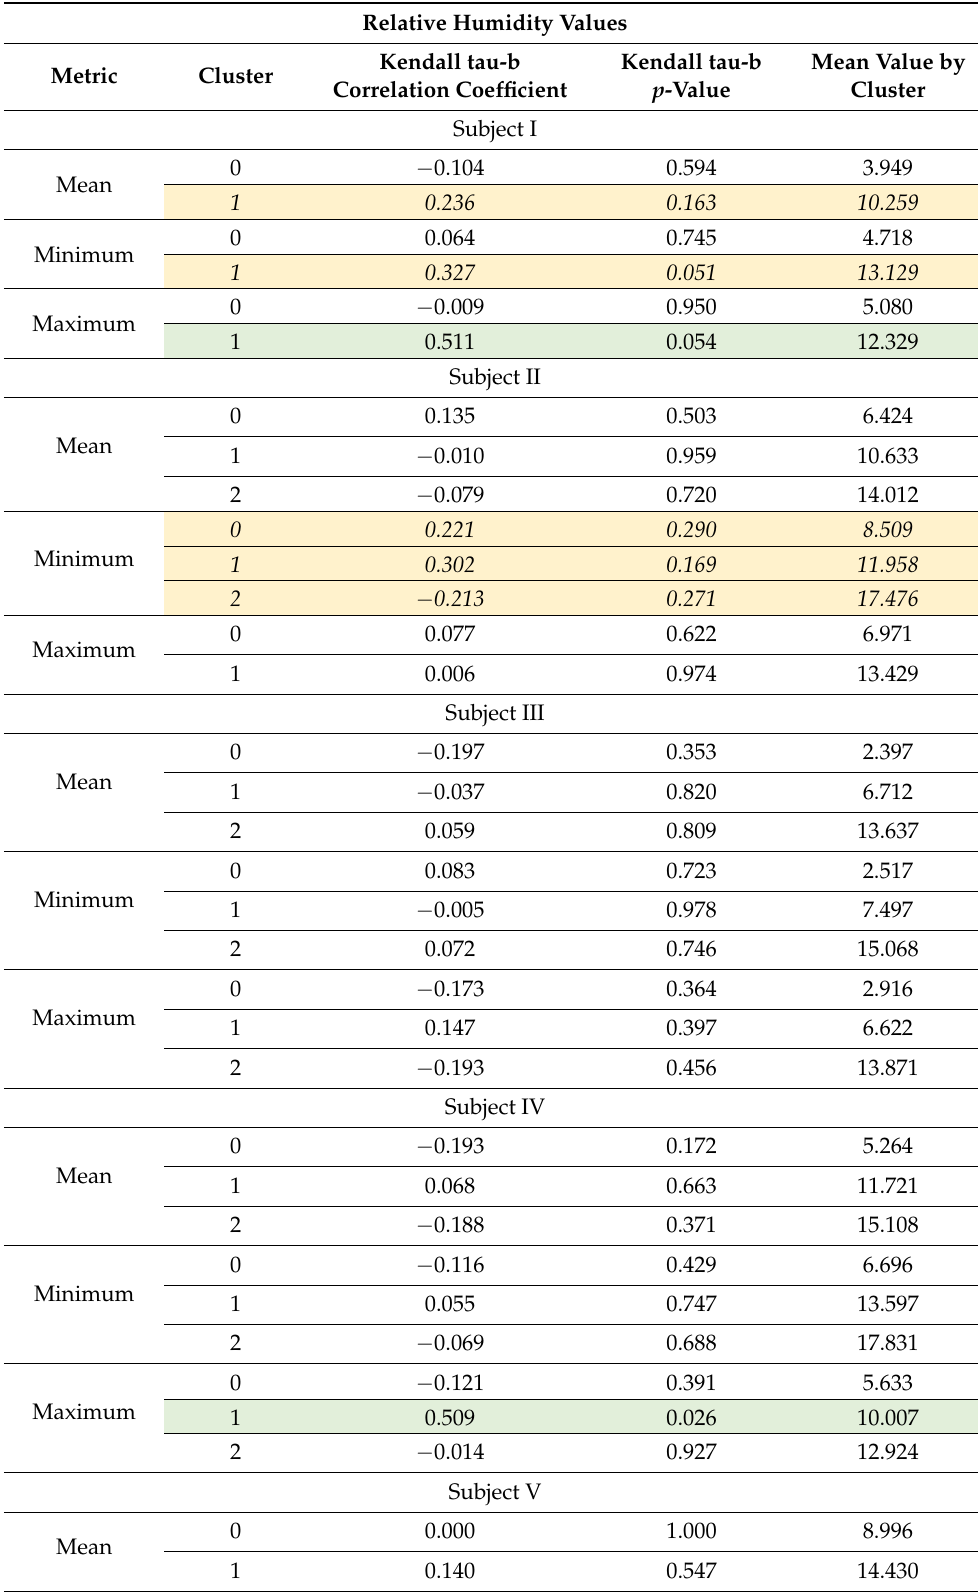
Table 5. Kendall tau-b statistical calculations of relative humidity by subject and